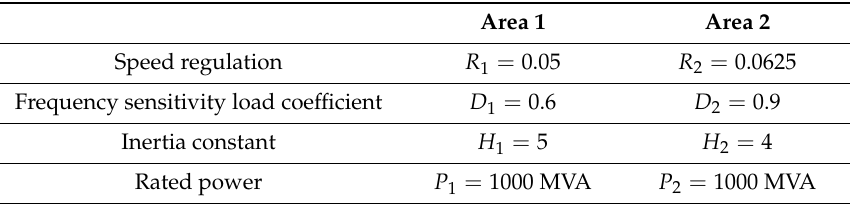
Table 1. The system parameters and loading